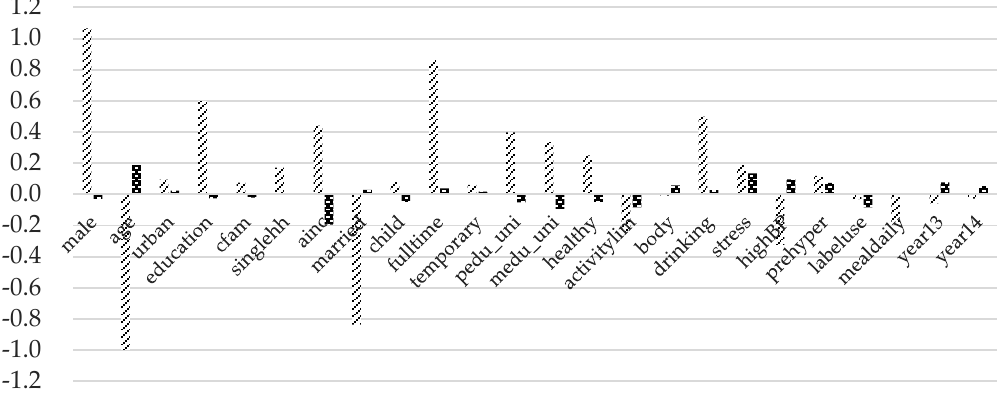
Figure 5. Standardized mean differences of treatment group 3. Note: Detailed explanations of the variables are included in Table 3.